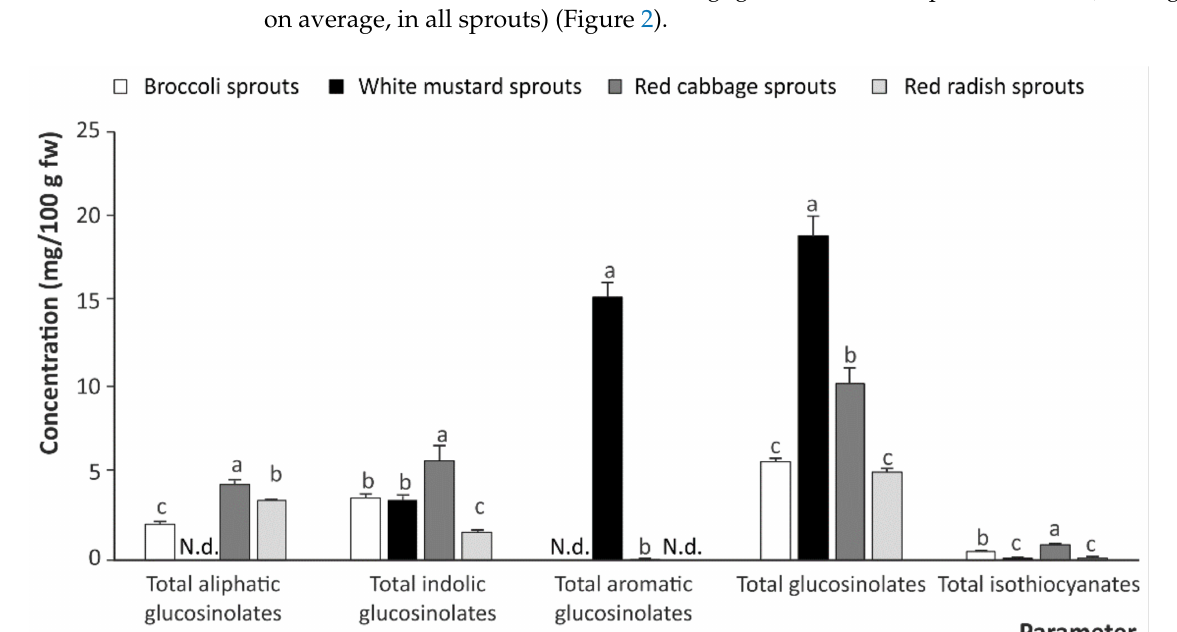
Figure 2. Total content of glucosinolates in undigested cruciferous sprouts. Mean values ± SD ( n = 3) for each family of glucosinolates with different lowercase letters are significantly different at p < 0.01 according to the analysis of variance (ANOVA) and Tukey’s multiple range test. N.d., not